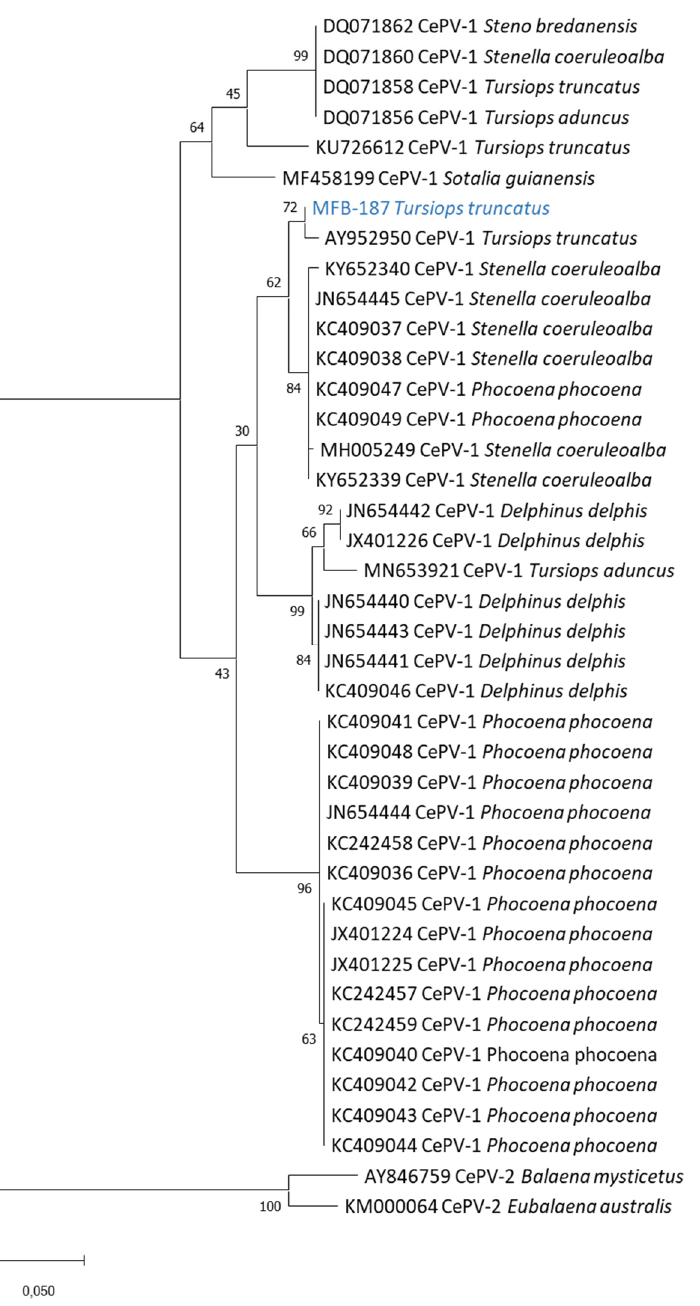
Figure 3. Phylogenetic analysis of CePV DNA polymerase nucleotide sequences obtained from tattoo skin lesions sampled in T. truncatus MFB-187. The phylogenetic tree was created using maximum-likelihood methods based on the Tamura three-parameter model [27]. Numbers represent bootstrap values for each node, calculated with 5000 replicates. For sequences extracted from databases, sequence information corresponds to the virus GenBank accession number following the sci- entific name of the cetacean species in which CePVs were detected. This analysis involved 40 nucle- otide sequences. There was a total of 458 positions in the final dataset. Evolutionary analyses were conducted in MEGA X [28].